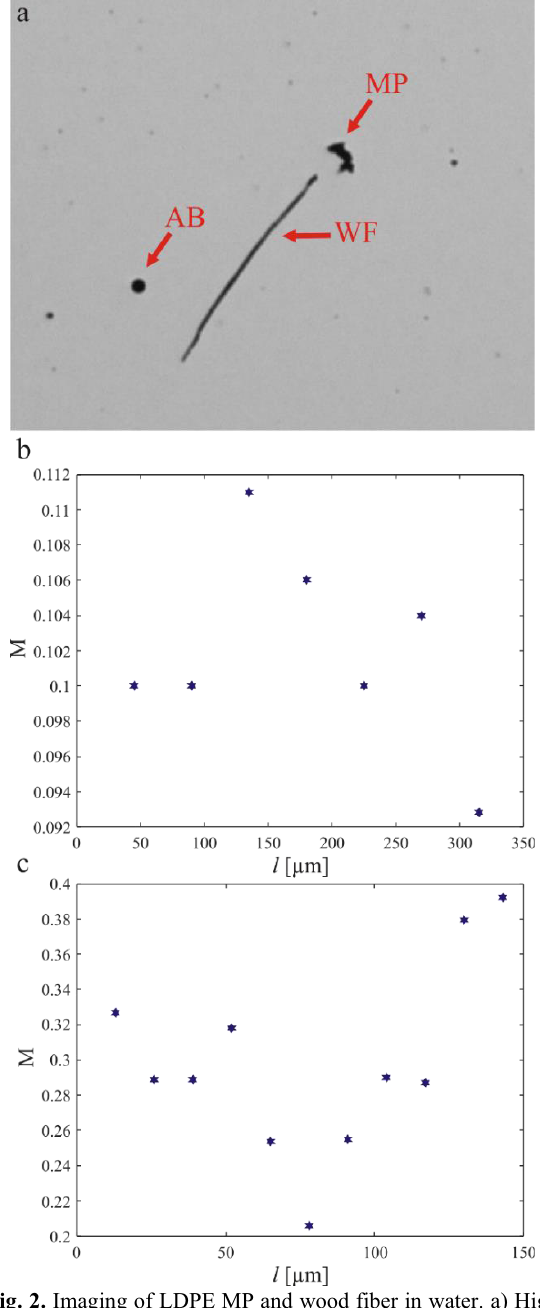
Fig. 2. Imaging of LDPE MP and wood fiber in water. a) High resolution initial image acquired with Valmet FS5 device. Intensity ratios calculated from a) for b) a MP, and c) a wood fiber (WF). AB stands for air